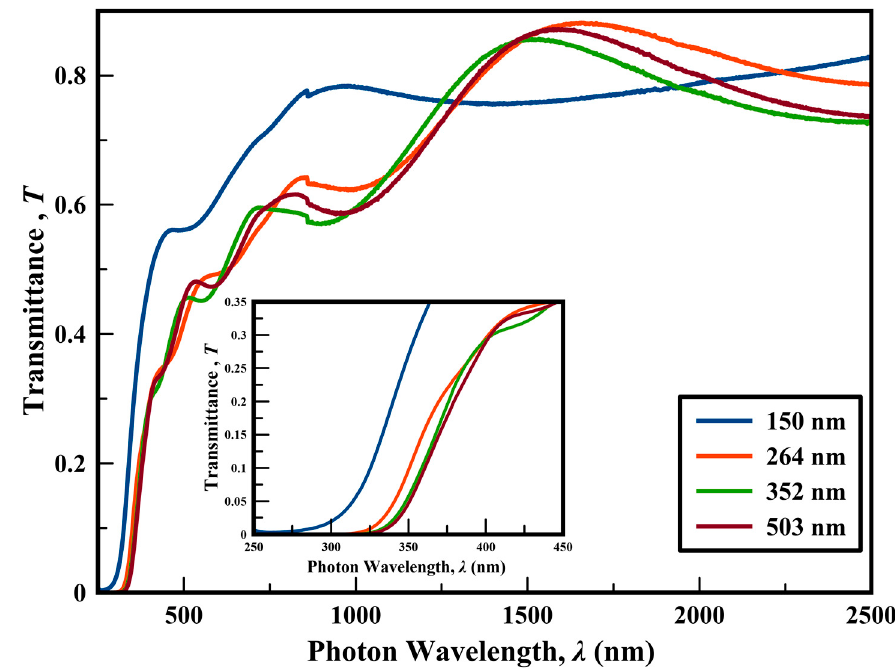
Figure 4. Optical transmittance of nickel oxide thin films.